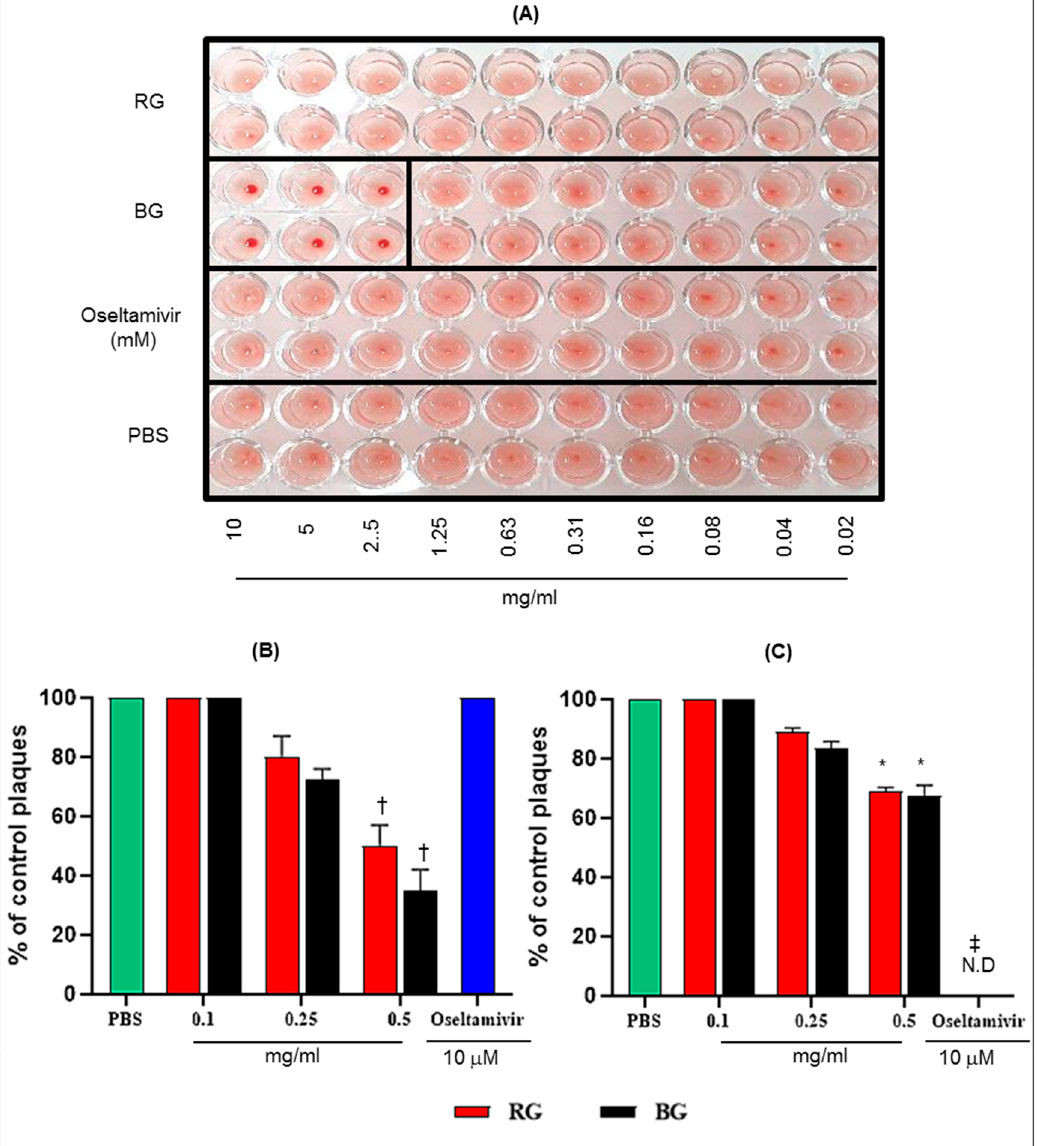
Figure 7. BG exhibits antiviral activities against A/California/04/2009 in vitro. ( A ) Hemagglutination inhibition (HI) assay conducted with PBS, RG, BG, and Oseltamivir with A/California/04/2009 in 96-well plates. A total of 0.02 to 10 mg/mL of each extract incubated with 4 to 8 HA unit of A/California/04/2009 virus for 60 min at RT and HI assay was conducted with 0.7% of turkey red blood cells (RBCs). Viral neutralization (plaque formation) assessments were performed in Madin-Darby Canine Kidney (MDCK) cells with ( B ) the pretreatment and ( C ) the posttreatment of BG against viral replication. The antiviral effect of BG was compared with RG and Oseltamivir treatment. Results are presented as the percentage of plaque reduction in each treatment group relative to the plaque formation in the PBS treatment group (negative control). Values are the mean ± SD *, p < 0.05 vs. PBS; †, p < 0.01 vs. PBS; ‡, p < 0.001 vs. PBS. N.D: Not detected.